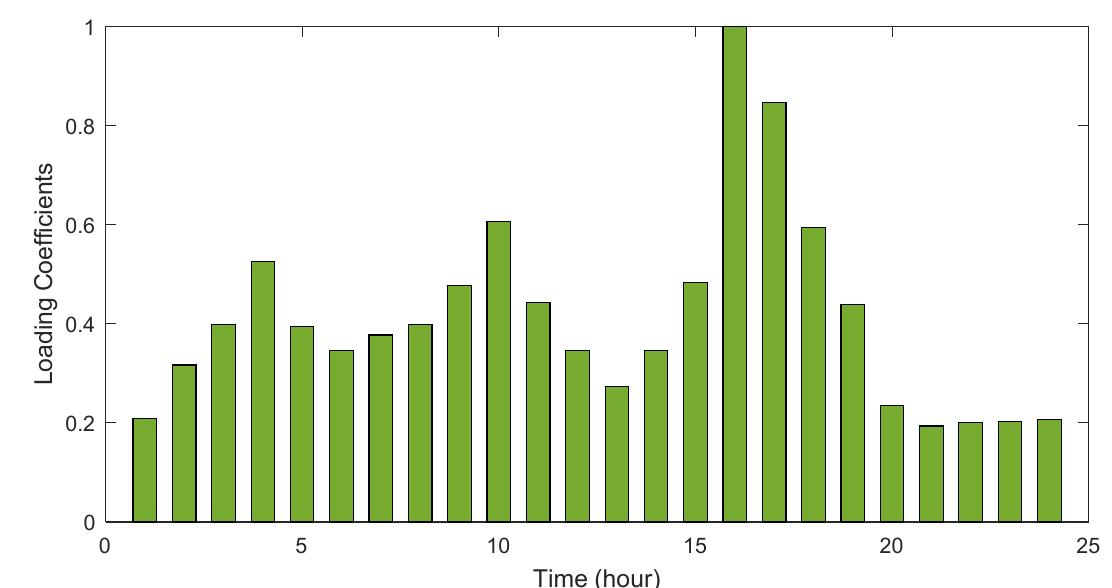
Figure 7. Loading coefficients of the distribution network for 24 h [34].